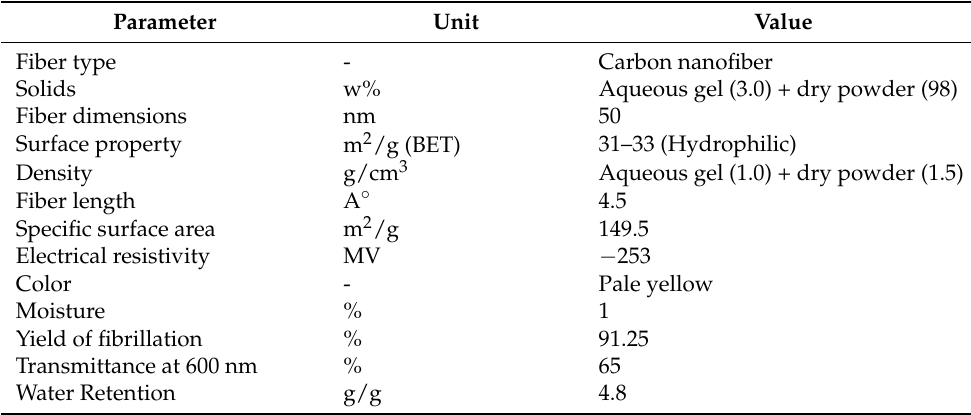
Table 3. The index properties of the CNF